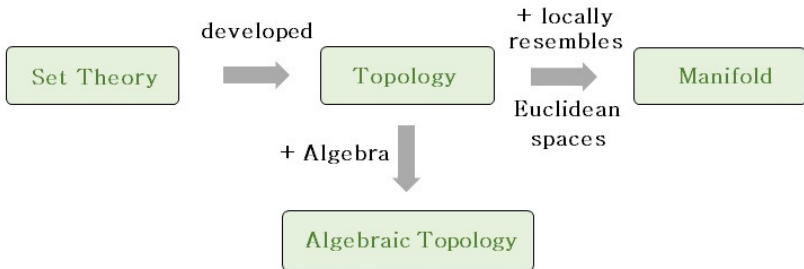
Figure 2. Main components of Section 2. This section is composed of four modules: set theory concepts; topology concepts developed from set theory; algebraic topology concepts (topology plus algebra); and manifold concepts (a topology that locally resembles Euclidean